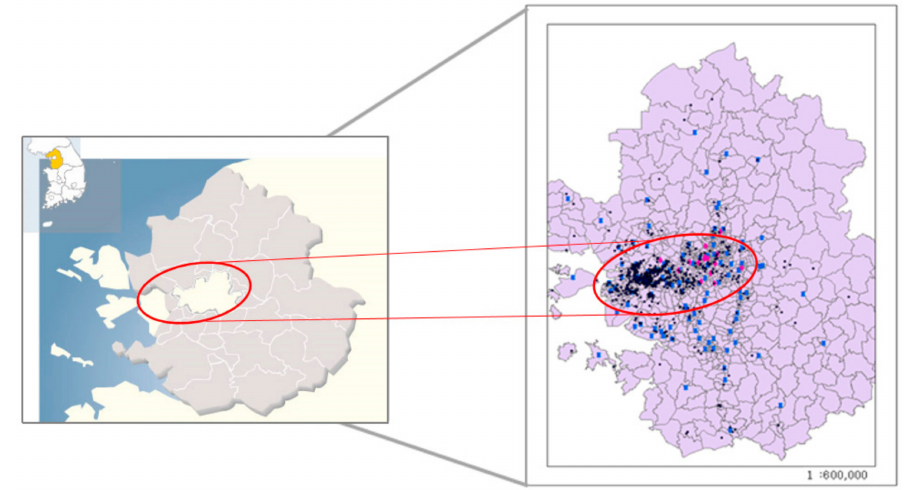
Figure 1. Locations of study areas (Seoul: white area in center, Incheon: white area in left side and Bucheon: between Incheon and Seoul) ( Left ) and residential (black dots) or air monitoring (blue dots) sites obtained from geographical information system ( Right